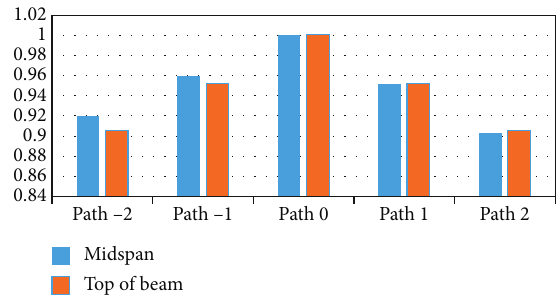
Figure 15: Lateral distribution frequency of vehicles.